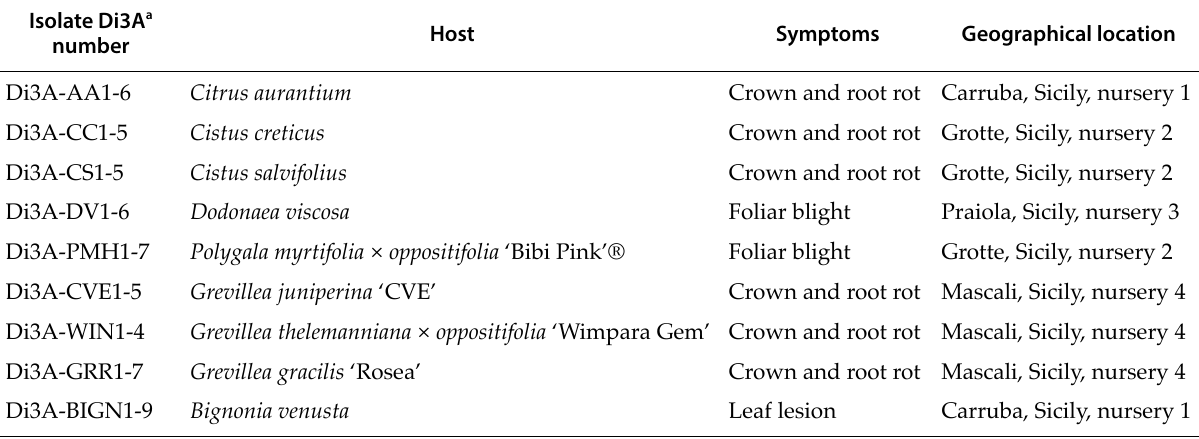
Table 1. Ornamental host species, disease symptoms and geographical location of Phytophthora spp. isolates collected from ornamental